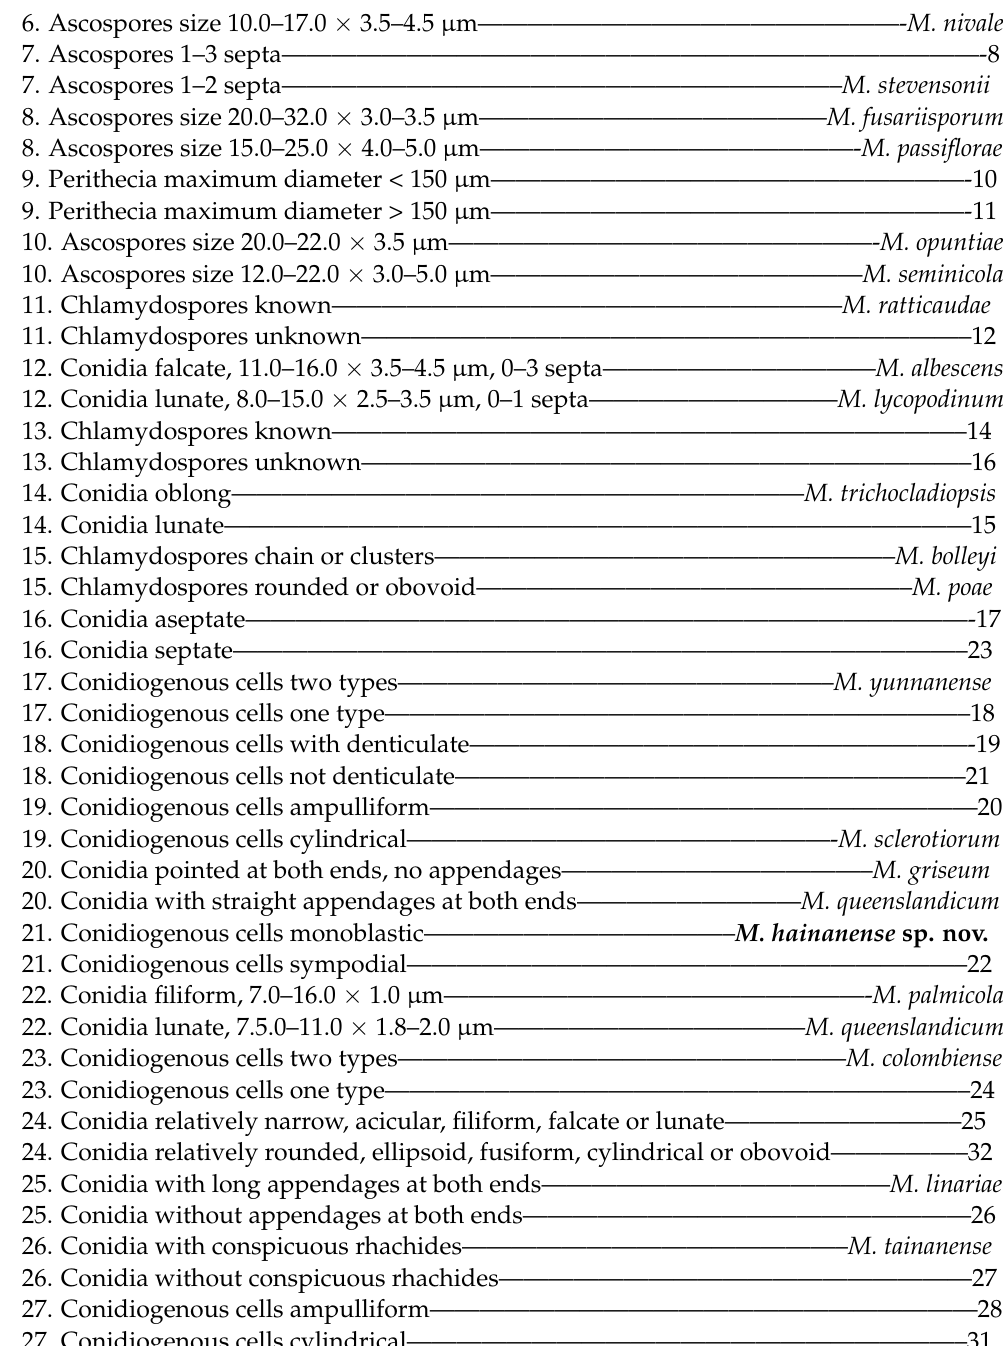
7. Ascospores 1–3 septa————————————————————————————-8 7. Ascospores 1–2 septa——————————————————————– M. stevensonii